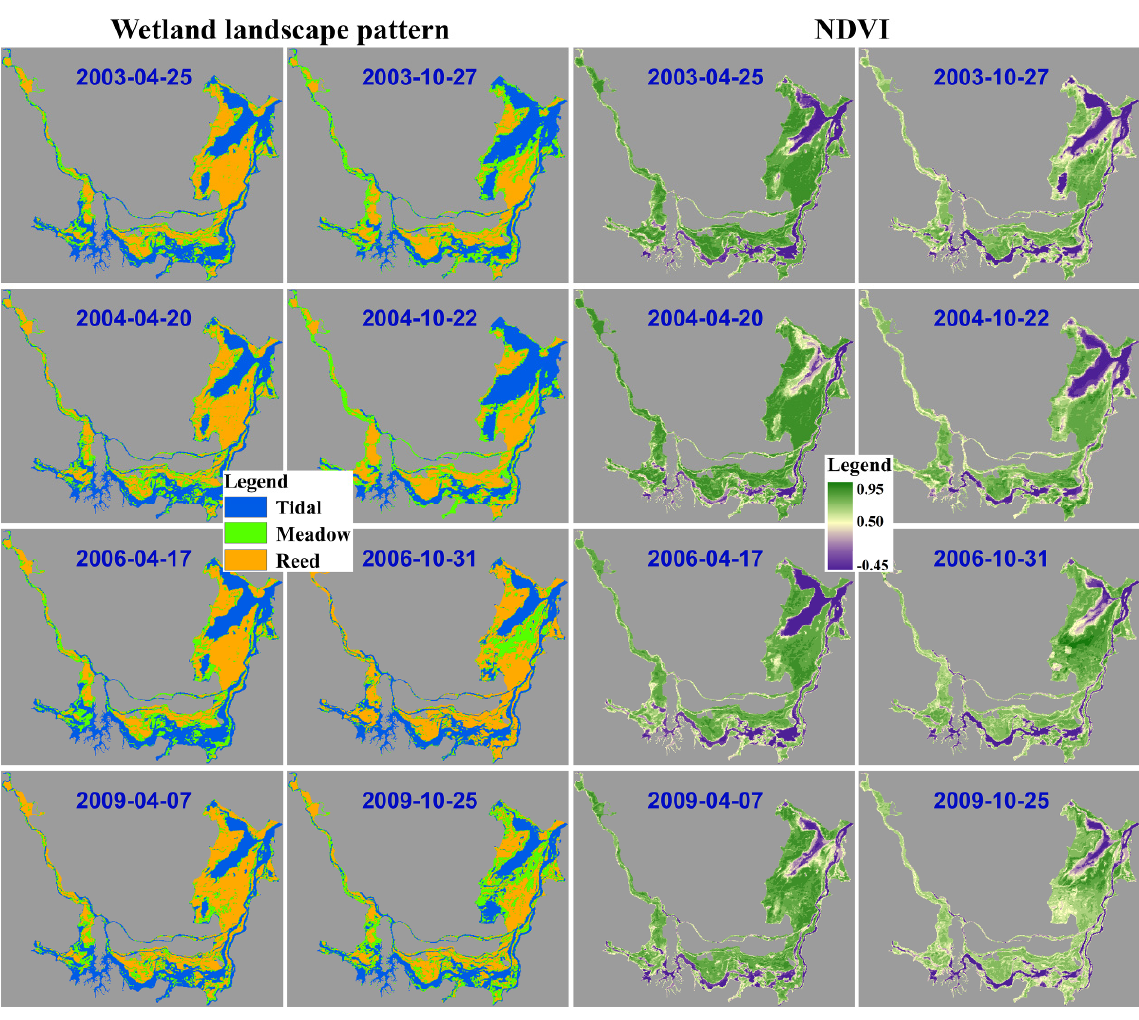
Figure 13. Changes in wetland landscape patterns and NDVI values of wetlands after the flood